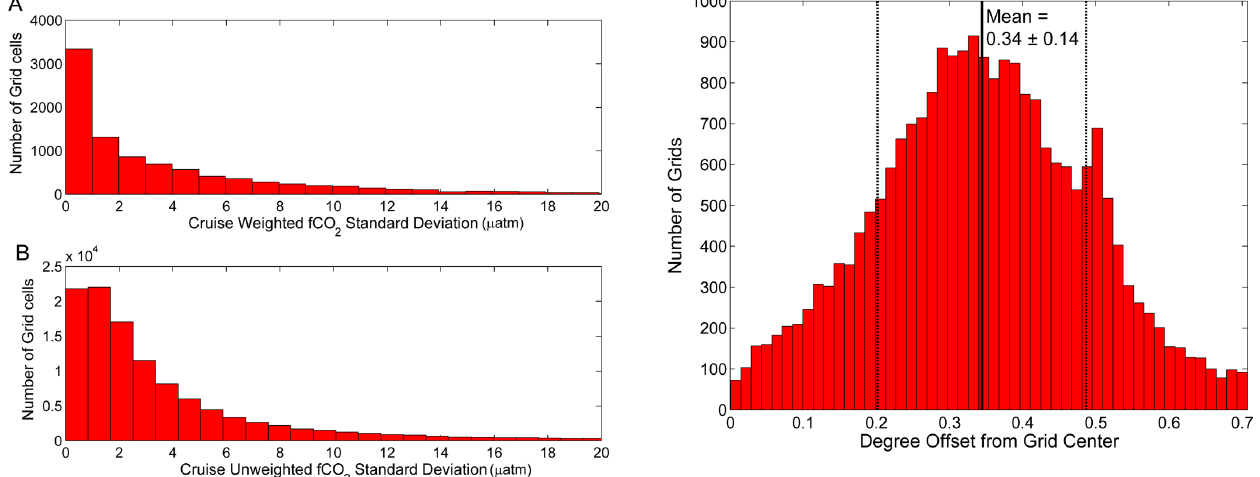
Figure 3. Histogram of the mean degree o ff set from grid center for all grid cells with values. The solid line shows the mean o ff set and the dashed bars show the standard deviation of the mean o ff set over all